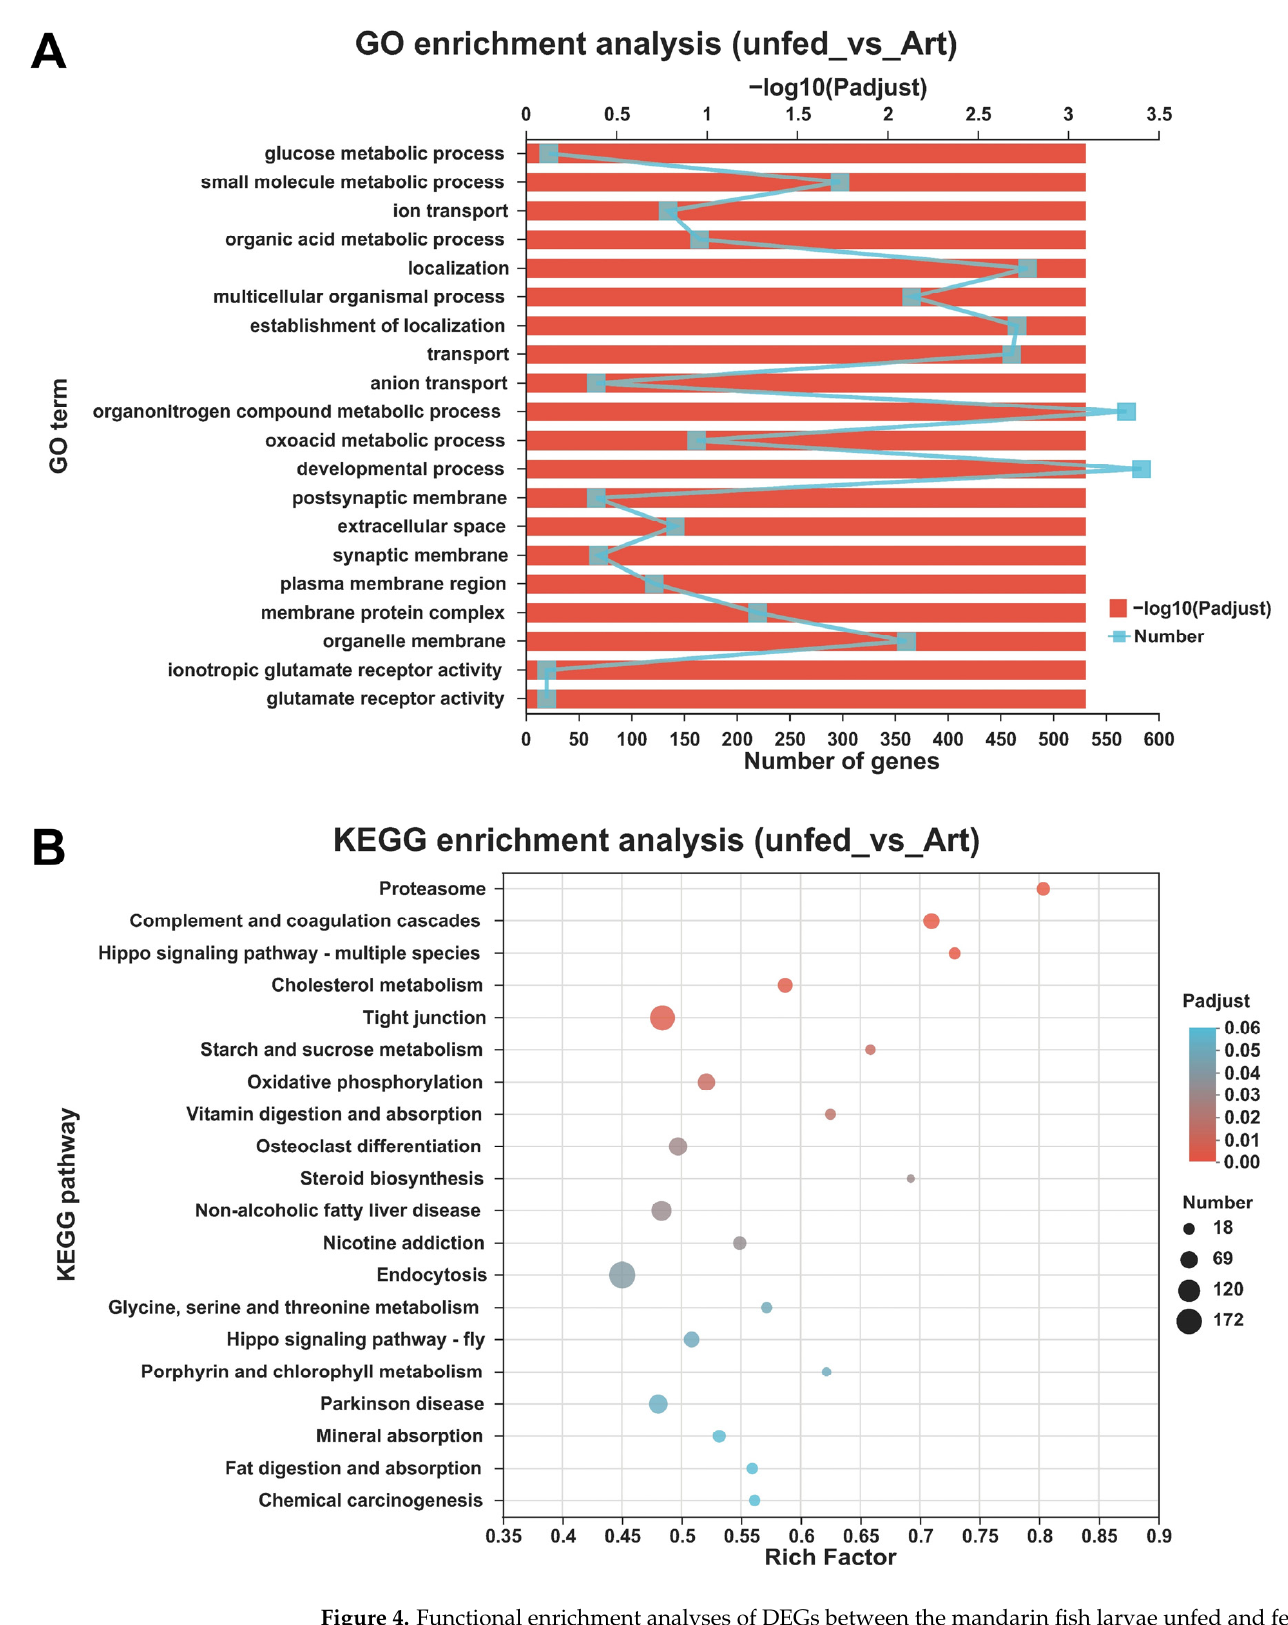
Figure 4. Functional enrichment analyses of DEGs between the mandarin fish larvae unfed and fed with brine shrimp. ( A ). Top 20 GO enrichment terms; ( B ). Top 20 KEGG enrichment